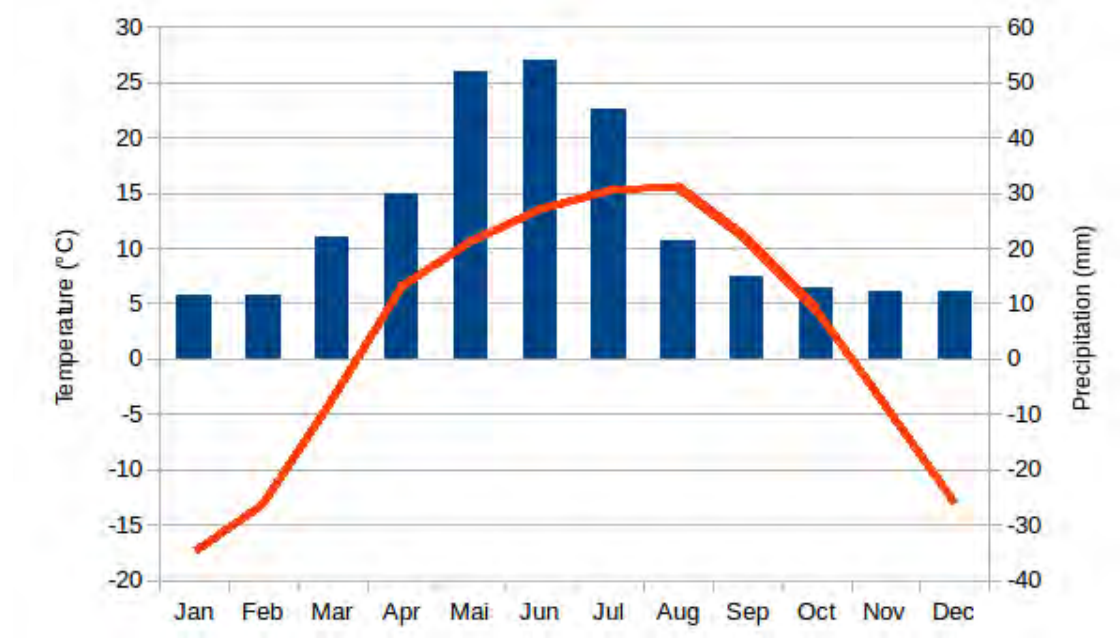
Figure 2. Climograph of weather station At-Bašy (75.80 °N, 41.20 °E), period: 1965–1994 (after Williams & Konovalov 2008).